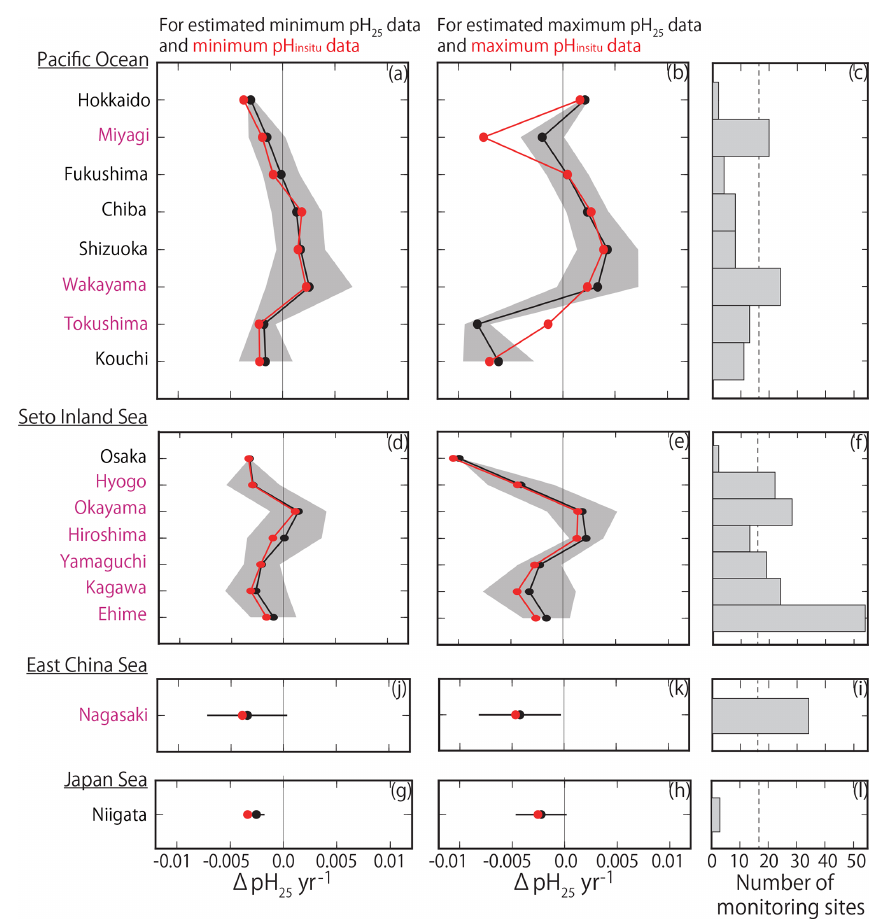
Figure 11. (a, b, d, e, g, h, j, k) Same as Fig. 9 but showing the average estimated minimum and maximum pH 25 trends ( (cid:49) pH 25 yr − 1 ) for each prefecture. Red lines and points indicate the average minimum and maximum pH insitu trends shown in Fig.